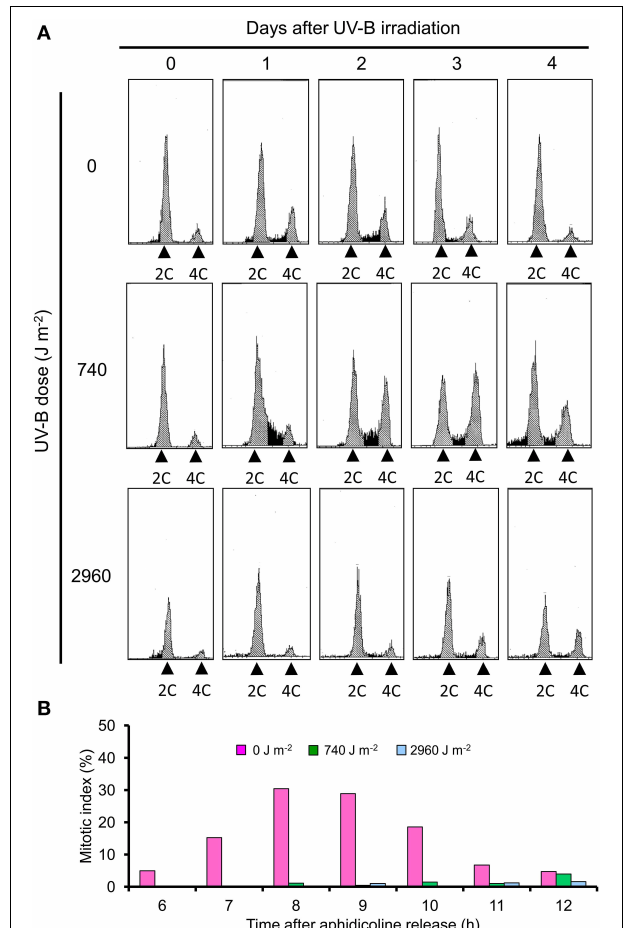
FIGURE 2 | Analysis of cell cycle progression in UV-B–irradiated BY-2 cells. (A) Cells irradiated with UV-B (0, 740, or 2960 J m − 2 ) were analyzed by flow cytometry. DNA ploidy distribution was measured with a ploidy analyzer (Partec, Germany). Typical data from at least two independent experiments are shown. (B) BY-2 cells were synchronized at S phase by aphidicolin and irradiated with UV-B (0, 740, or 2960 J m − 2 ) after release. Mitotic index was determined at indicated time points. Typical data from at least two independent experiments are